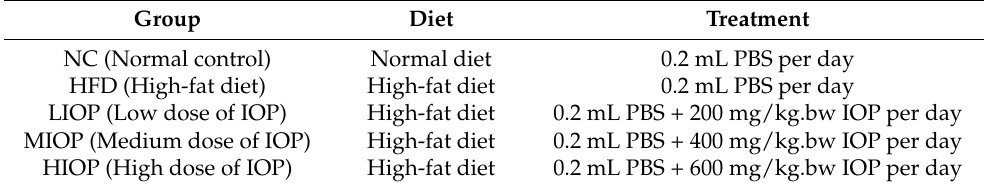
Table 1. Treatment for experimental mice. Group